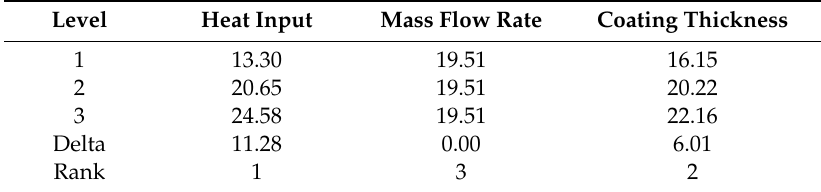
Table 8. Response Table for SNRA.